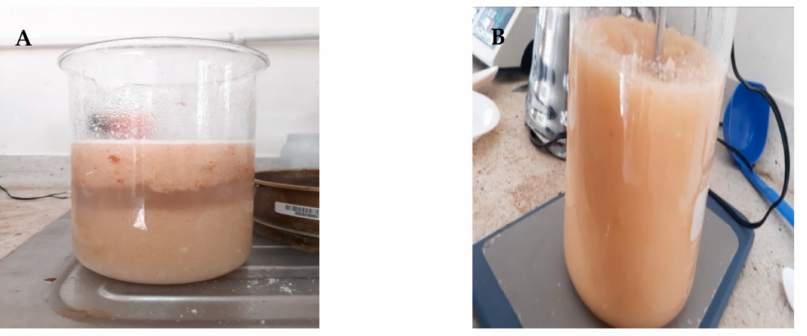
Figure 2. OD at 75% NaCl and solution to sample ratio of 4:1; ( A ) without agitation; ( B ) stirred at 320